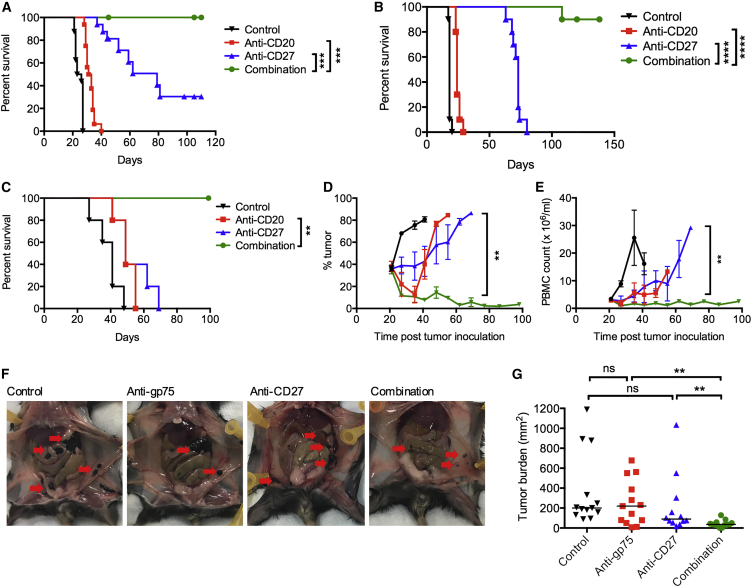
Anti-CD27 in Combination with a Tumor-Targeting mAb(A) BCL1-bearing mice were treated with isotype control, anti-CD20 (200 μg) on day 4, anti-CD27 (100 μg) on days 5–8, or in combination. Graph shows n = 15 per group, representative of three independent experiments.(B) A31-bearing mice were treated with isotype control, anti-CD20 (200 μg) on days 4 and 14, anti-CD27 (100 μg) on days 5–8 and 15–18, or in combination. Graph shows n = 10 per group, compiled from two independent experiments. Data were assessed using log-rank test; ∗∗∗p < 0.001, ∗∗∗∗p < 0.0001.(C–E) Eμ-TCL1-bearing mice were treated with anti-CD20 (250 μg) or anti-CD27 (100 μg) the next day, or the combination, >3 weeks post-tumor inoculation when peripheral tumor was >10%. Graphs show n = 6/group, representative of two independent experiments. Animal survival (C), peripheral blood tumor burden (D), and total PBMC count (E). Mean and SEM shown. Log-rank test was used in (C) and Mann-Whitney test in (D and E); ∗∗p < 0.01.(F and G) C57BL/6 mice were inoculated with 50,000 B16F10 tumor cells intraperitoneally on day 0, and treated with anti-gp75 (50 μg) on day 0 and anti-CD27 (100 μg) on day 1 (all intraperitoneally). Mice were harvested on day 13, and peritoneal metastases were measured. Representative photographs are shown in (F), with metastases highlighted by the red arrows. The graph in (G) shows data accumulated from two experiments, n = 11–12 mice per group. Mann-Whitney test was used to assess the p value; ∗∗p < 0.01. See also Figures S1.